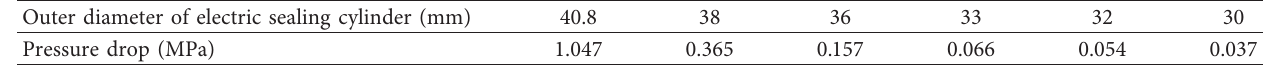
Table 1: Pressure drop corresponding to change of the outer diameter of the electric sealing